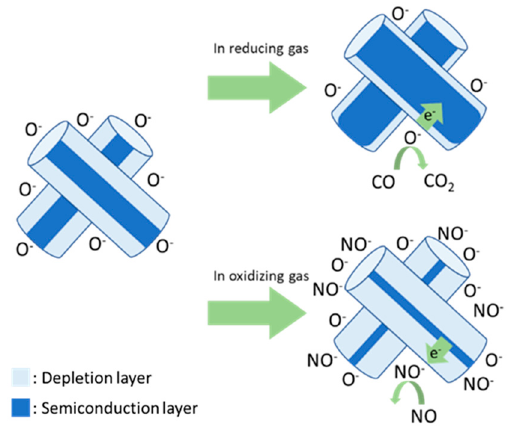
Figure 1. Schematic model of n-type semiconductor gas sensors.